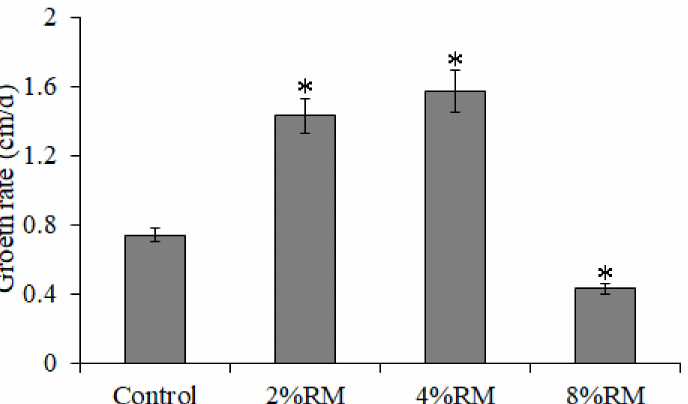
Figure 4. Growth rate of P. ostreatus mycelia on a cottonseed hull medium with different concen- trations of R . roxburghii must. * indicates a significant difference at p < 0.05 compared with the control group.